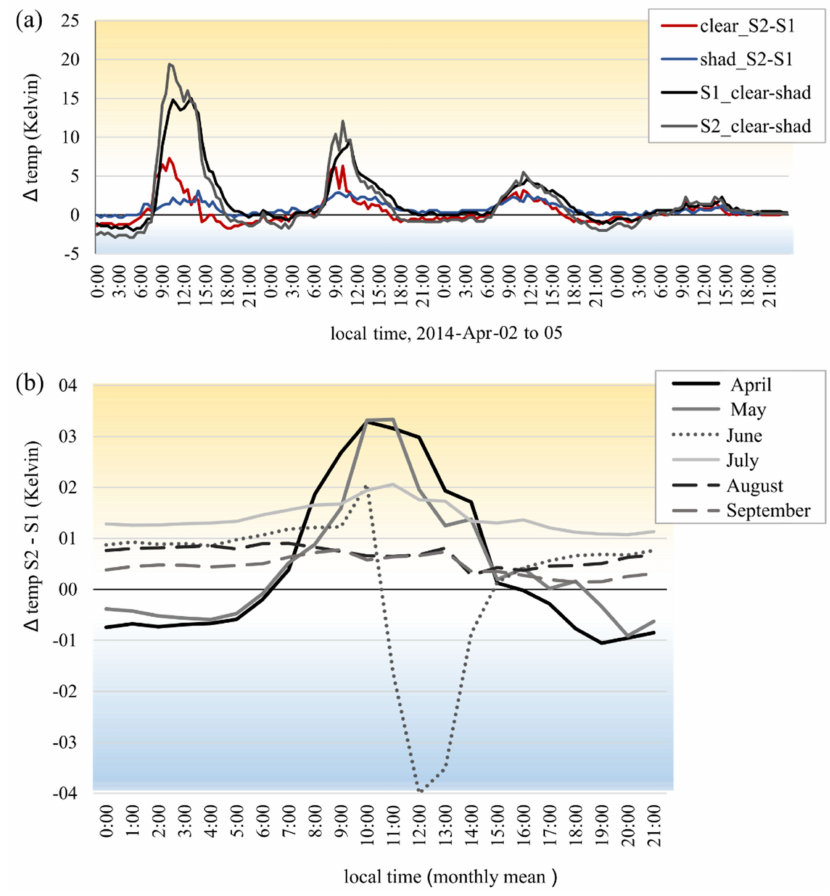
Figure 3. Temperature deviations between S1 and S2 ( a ) according to sensor system and location and ( b ) along the season. ( a ) Temperature differences of the two systems (S2 minus S1) at “wide clearing” (clear, in red) and “tree shadow” (shad, in blue) and differences between the locations looking at S1 (black) or S2 (grey) from April 2 to 5. Sunshine duration considerably decreased in the course of the days (h/day: 10.2, 3.1, 0, 0); ( b ) the lower graph depicts differences between S1 (ML-1) and S2 (ML-7) at “wide clearance” as hourly mean values from spring to autumn 2014. The differences between the sites (Figure 3a, black and grey lines) were distinctly larger than the observed differences between the systems at one site (Figure 3a, red and